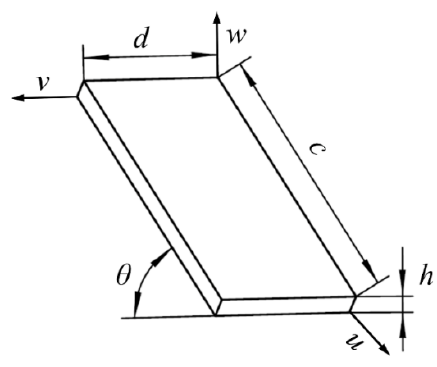
Figure 2. Schematic of the rectangular thin plate.